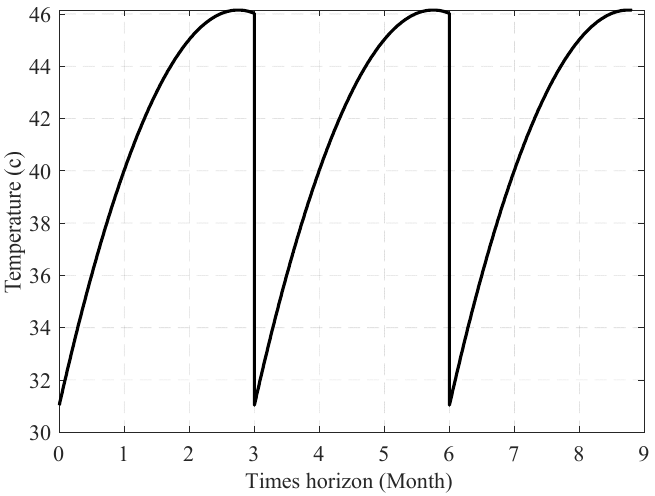
Figure 18. Assumed lubricant temperature (first fault scenario).